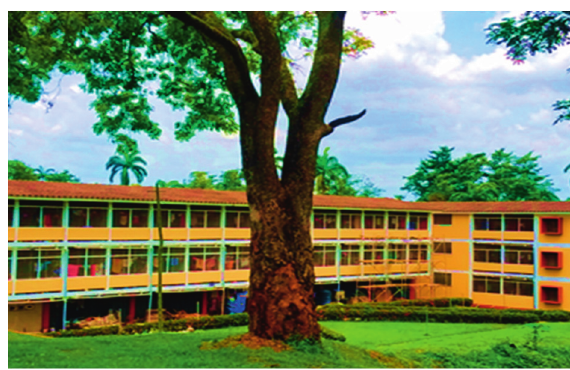
Figure 1: Khaya senegalensis